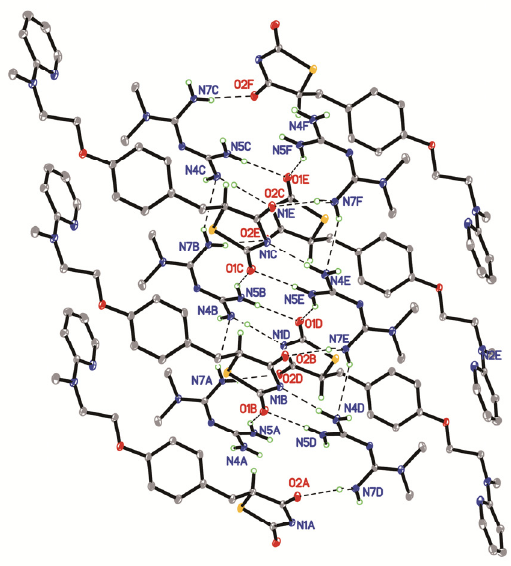
Figure 4. Two dimensional layered structure connected by hydrogen bonds of Rsg-Met.